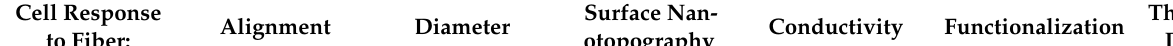
Table 4. Summary of central nervous system glial cell response to various electrospun fiber properties in vitro. Cell